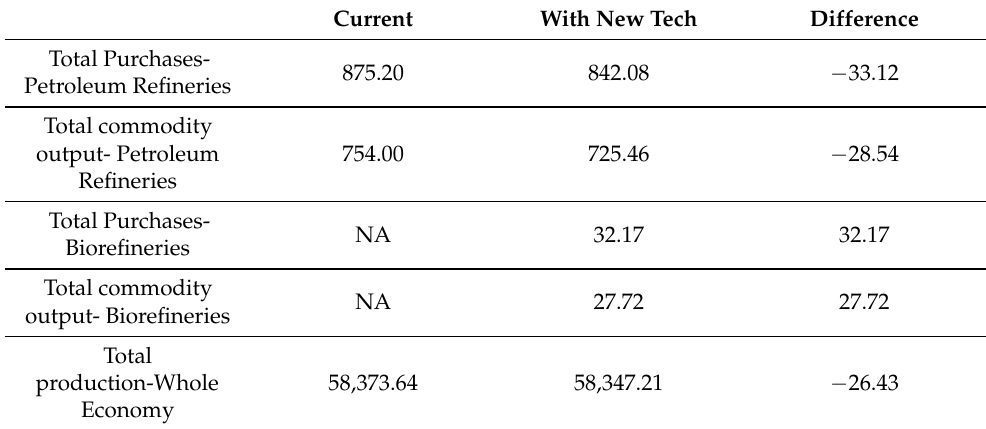
Table 1. Whole economy economic comparative results with 3.68% substitution. In billion USD.